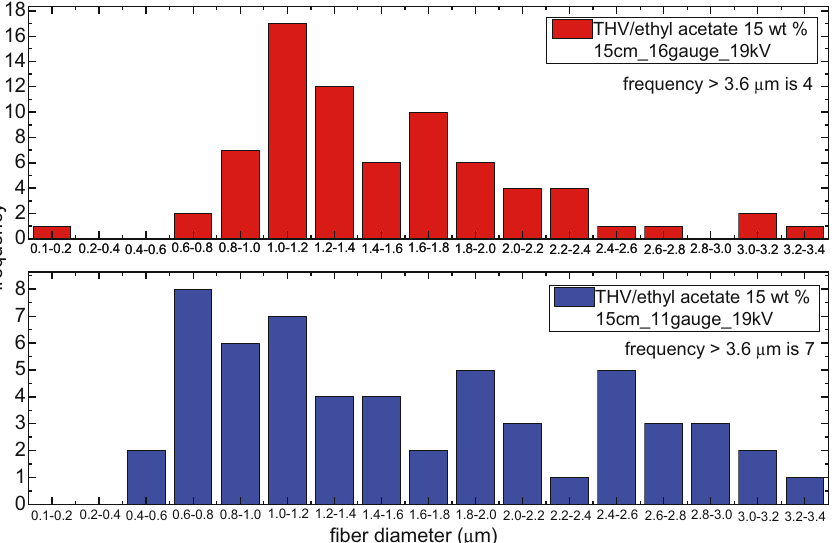
Figure 5: Histogram of fi ber diameter distribution when the fi bers were prepared from 15 wt% THV/ethyl acetate